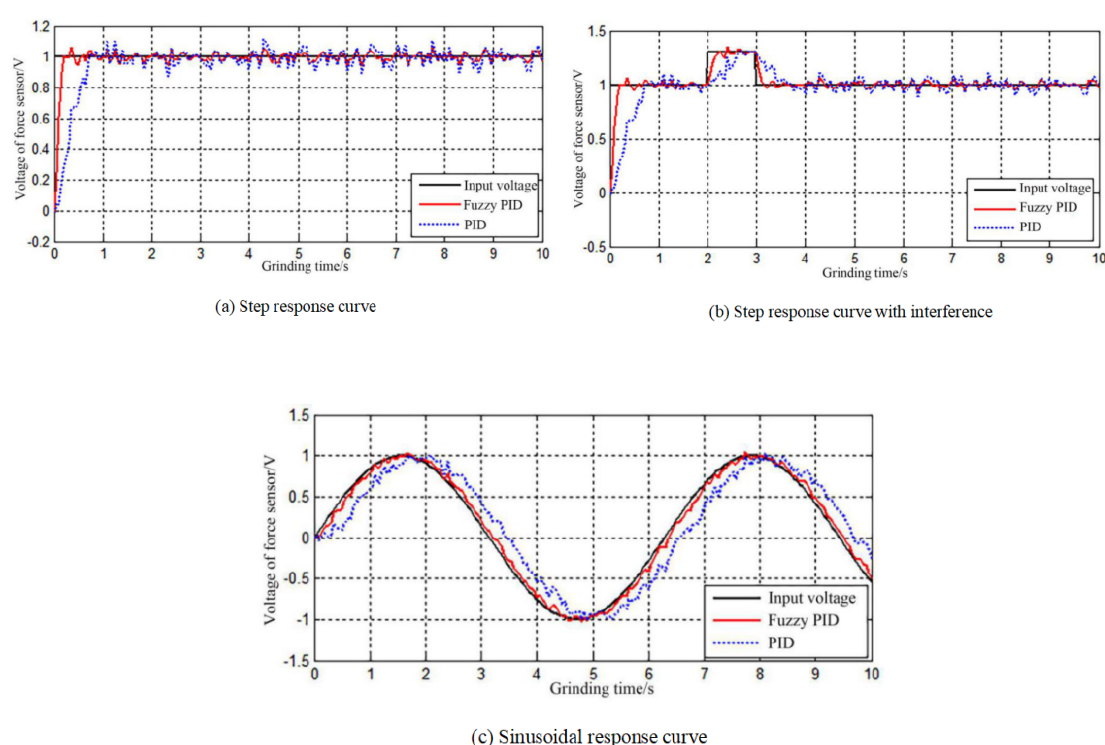
Figure 11. Response curve of the polishing experiment (Spindle speed is